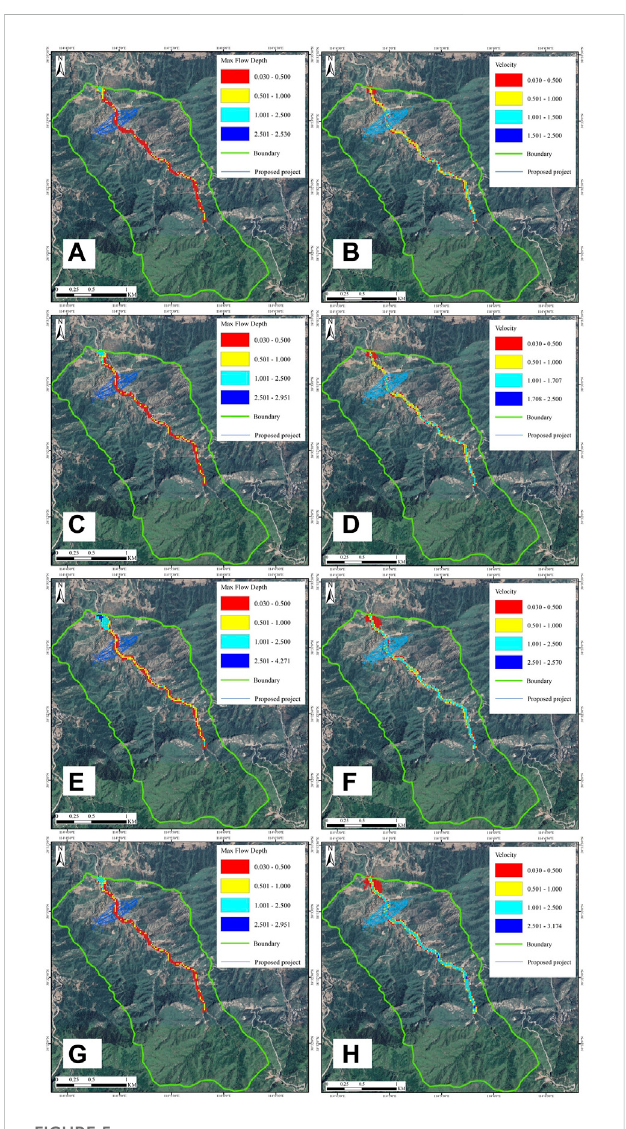
FIGURE 5 Maximum fl ow depths and velocities at various rainfall frequencies. (A) (a)Distribution of10-yearmaximum fl owdepth(m) (B) (b)Distribution of 10-year velocity (m/s), (C) (c) Distribution of 20-year maximum fl ow depth (m), (D) (d) Distribution of 20-year velocity (m/s), (E) (e) Distribution of 50-year maximum fl ow depth (m), (F) (f) Distribution of 50-year velocity (m/s), (G) (g) Distribution of 100-year maximum fl ow depth (m), (H) (h) Distribution of 100-year velocity